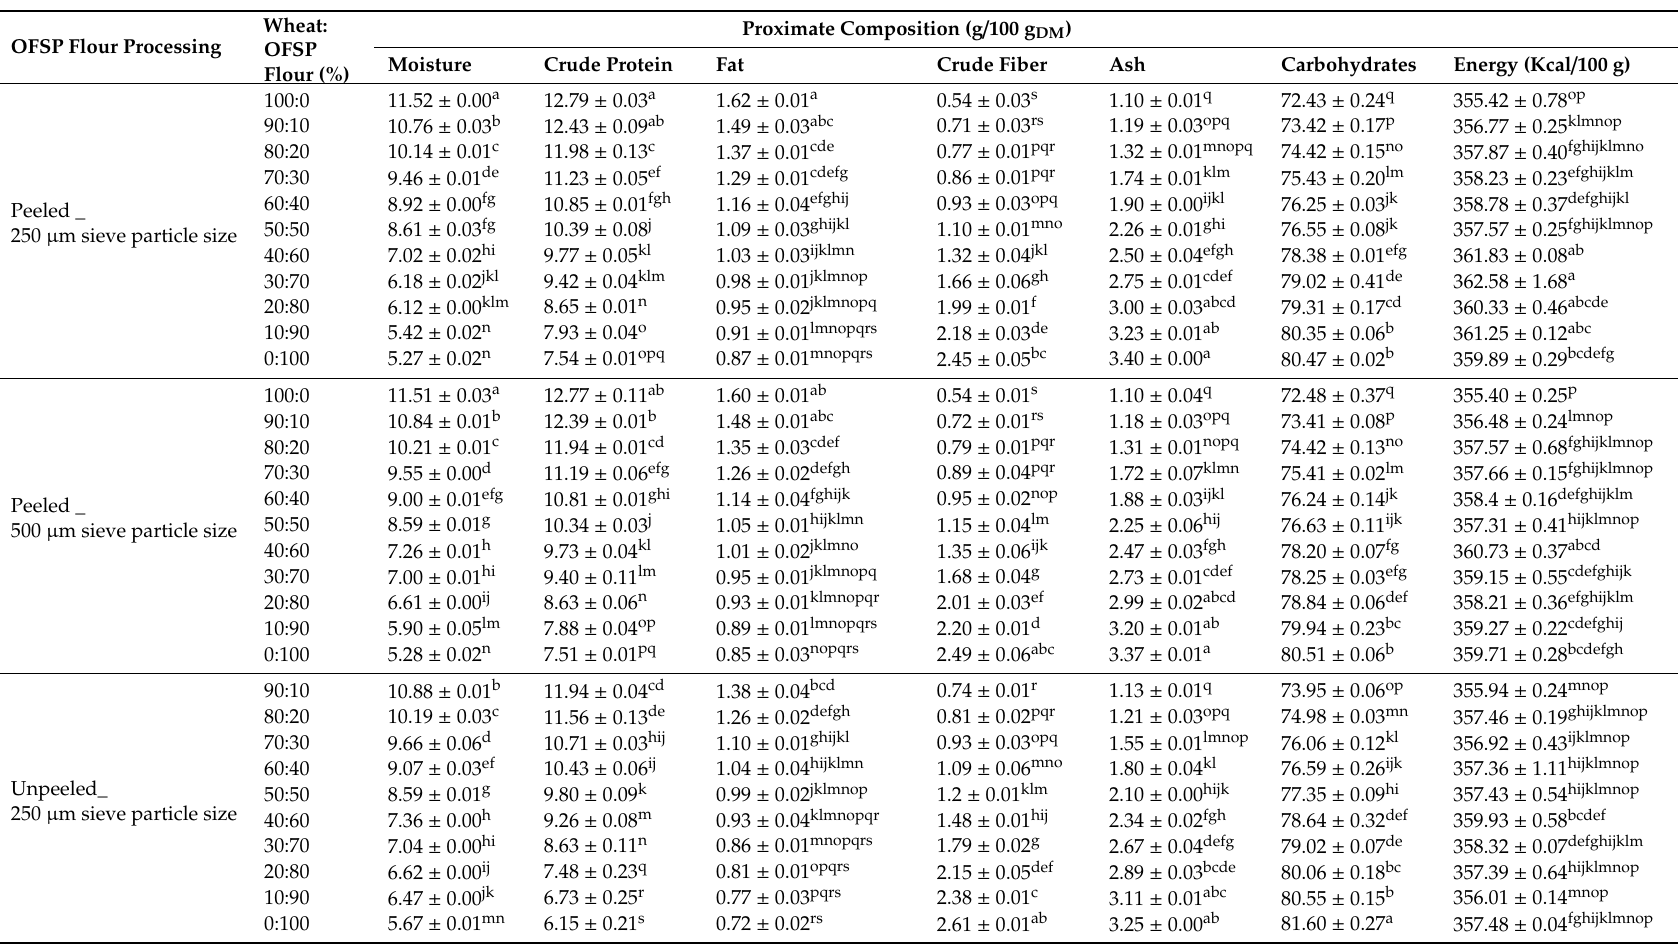
Table 1. E ff ect of sieve particle size and blend proportion on proximate composition and energy value of peeled and unpeeled OFSP composite flours. OFSP Flour